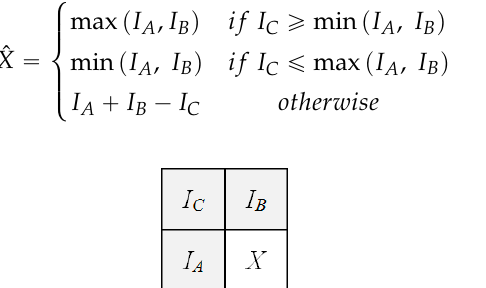
Figure 1. The prediction context of the 2D-LMP predictive structure. The gray part is already coded and the white part is not coded yet.